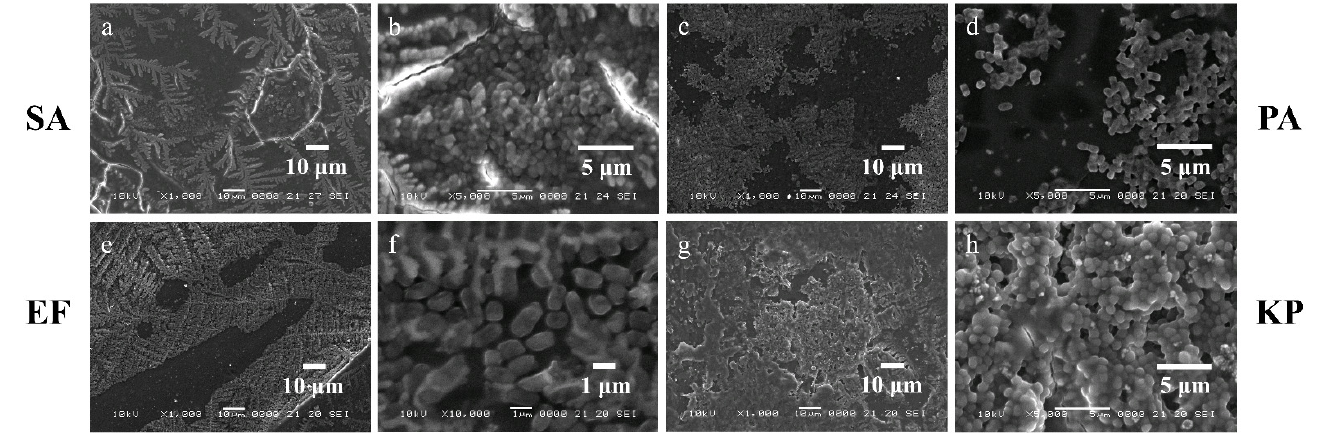
Figure 13. SEM images of biofilms grown under static conditions for SA ( a , b ), PA ( c , d ), EF ( e , f ), and KP ( g , h ) at magnifications of ×1000 ( a , c , e , g ), and ×5000 ( b , d , f , h ).